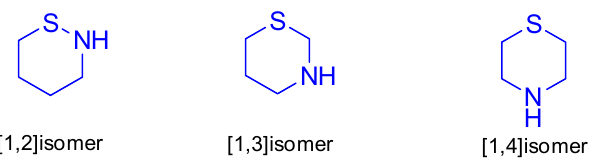
Figure 1. Isomeric forms of thiazinane.